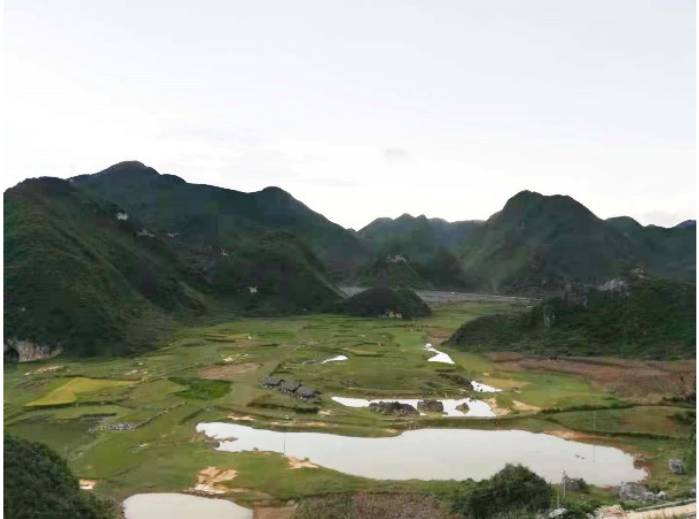
Figure 8. Example of agricultural eco-tourism model (karst landscape).